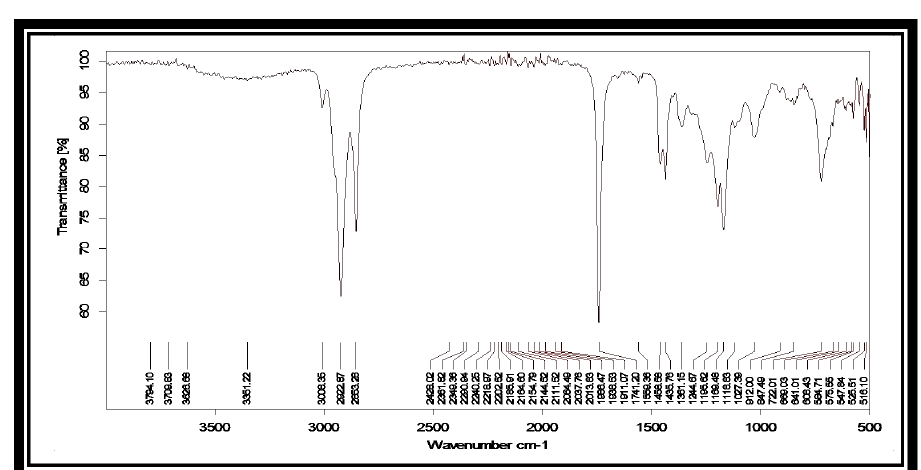
Figure 1. FTIR of diesel fuel.